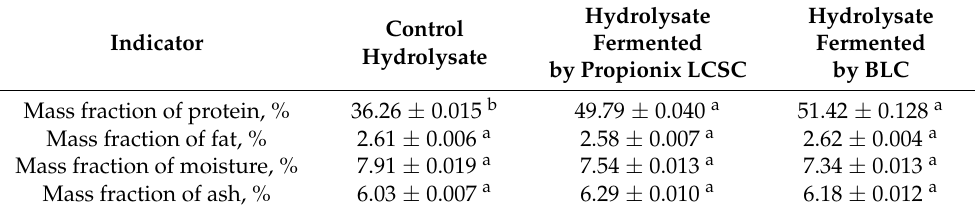
Table 1. Physicochemical indicators of protein hydrolysates. Indicator